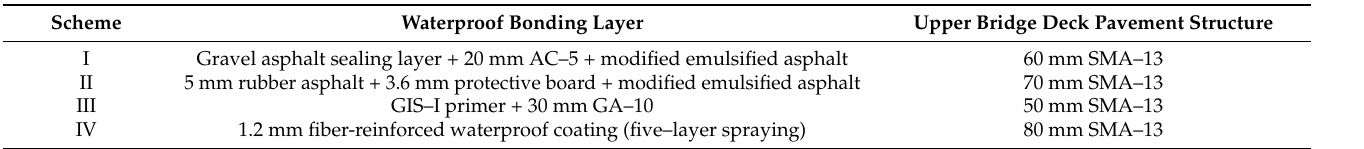
Table 1. Cement concrete bridge deck systems.